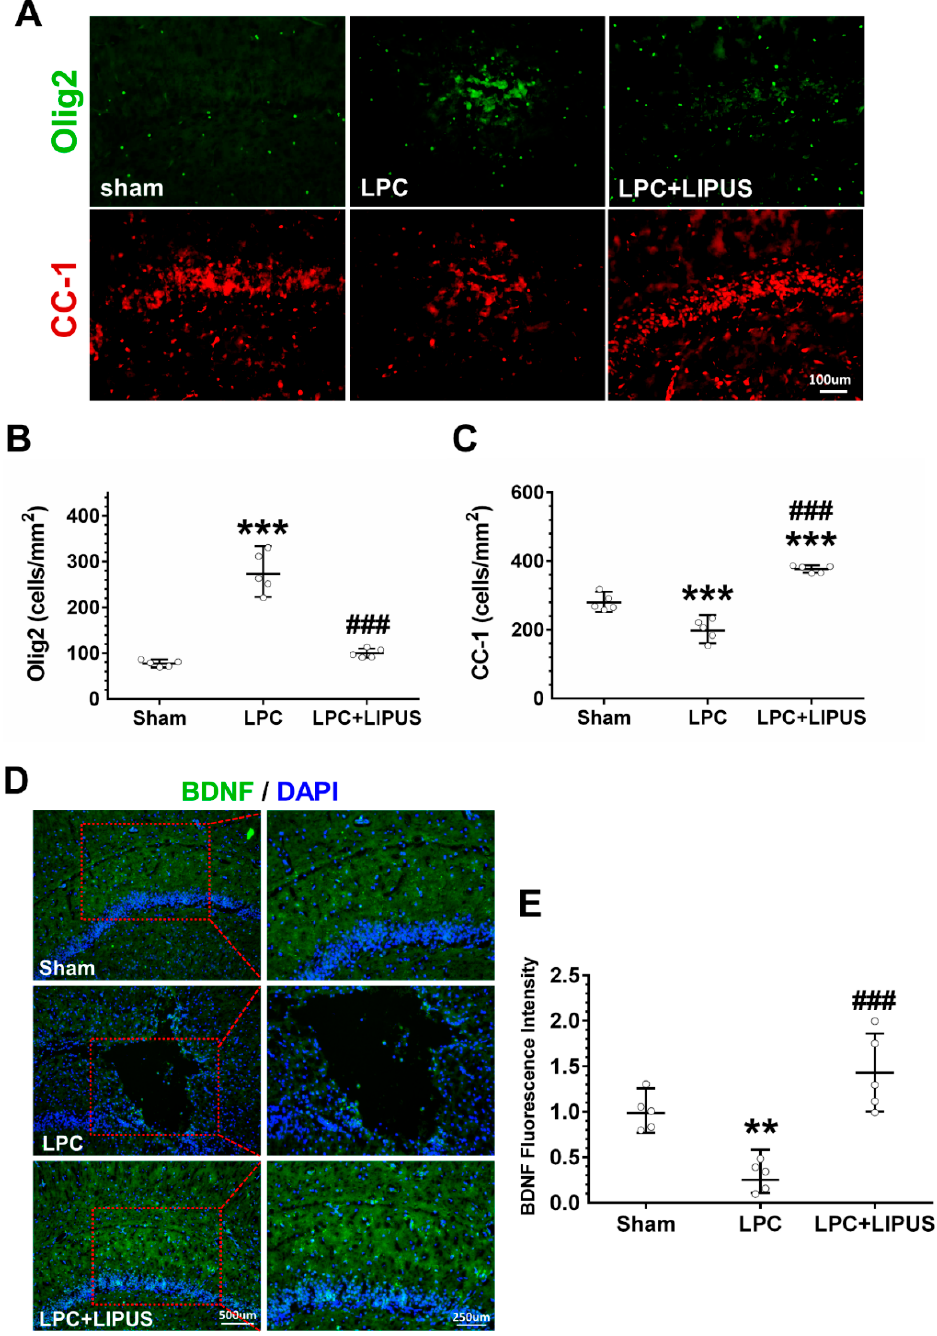
Figure 4. A reduction in Olig2 + cells and an increase in CC-1 + cells and the BDNF level were observed in LPC-induced lesions following LIPUS treatment. ( A ) Representative immunofluorescent staining of Olig2 + (green) and CC-1 + (red) in the vicinity of the demyelination lesion. Scale bar = 100 µ m. Quantification of ( B ) Olig2 + and ( C ) CC-1 + cell numbers in the LPC and LPC+LIPUS groups compared to the sham group. ( D ) Representative immunostaining for BDNF in LPC-induced lesions. Left column: scale bar = 500 μ m and, in the right column, 250 μ m. ( E ) The fluorescence in- tensities of BDNF were significantly decreased in the LPC group compared with the sham group. Compared with the levels observed in the LPC group, the BDNF expression significantly increased